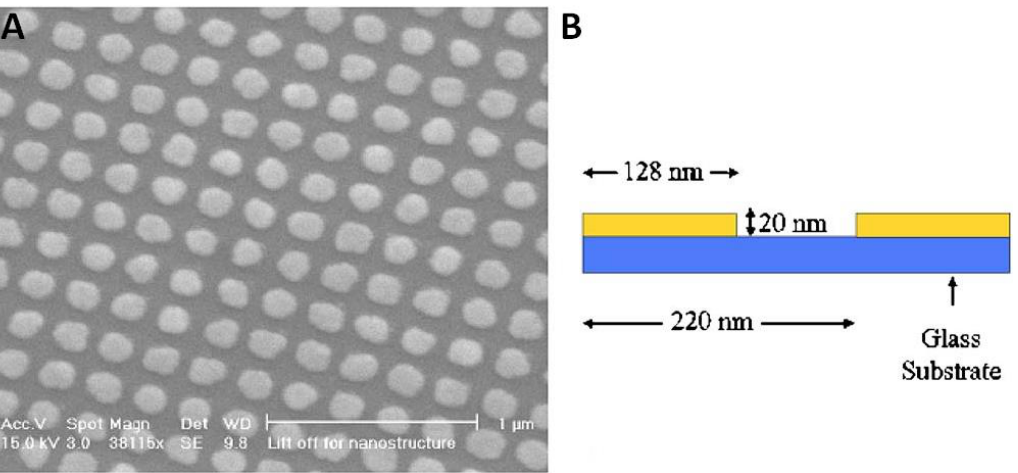
Figure 1. ( A ) Scanning electron microscope (SEM) picture of the two-dimensional (2D) Au nanostructure (top view); and ( B ) schematic of the 2D Au nanostructure on a substrate (side view). Reproduced with permission from [43], AIP Publishing,